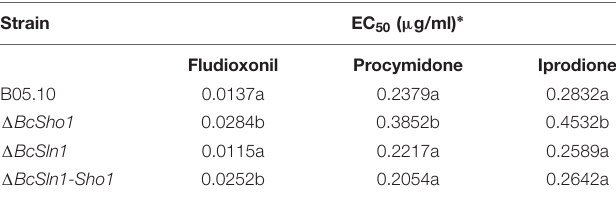
TABLE 1 | Sensitivity of the wild-type strain B05.10, the BcSHO1 deletion mutant (cid:49) BcSho1 , the BcSLN1 deletion mutant (cid:49) BcSln1 , and the BcSHO1 and BcSLN1 double deletion mutant (cid:49) BcSln1-Sho1 to different fungicides.